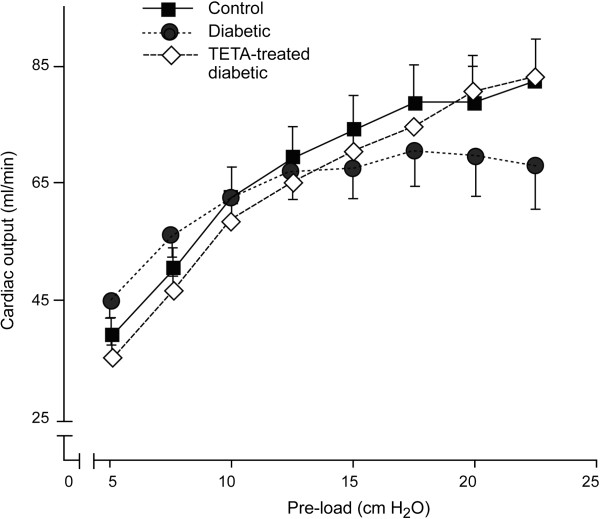
Response of CO to increasing preload in ex vivo isolated-perfused working hearts from experimental groups of Control (n = 12), Untreated-Diabetic (n = 12) and Trientine-treated Diabetic (n = 13) adult male rats. Abbreviation: TETA, triethylenetetramine.